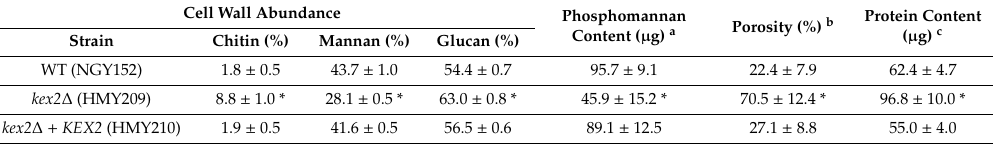
Table 2. Cell wall composition of Candida albicans kex2 ∆ and control